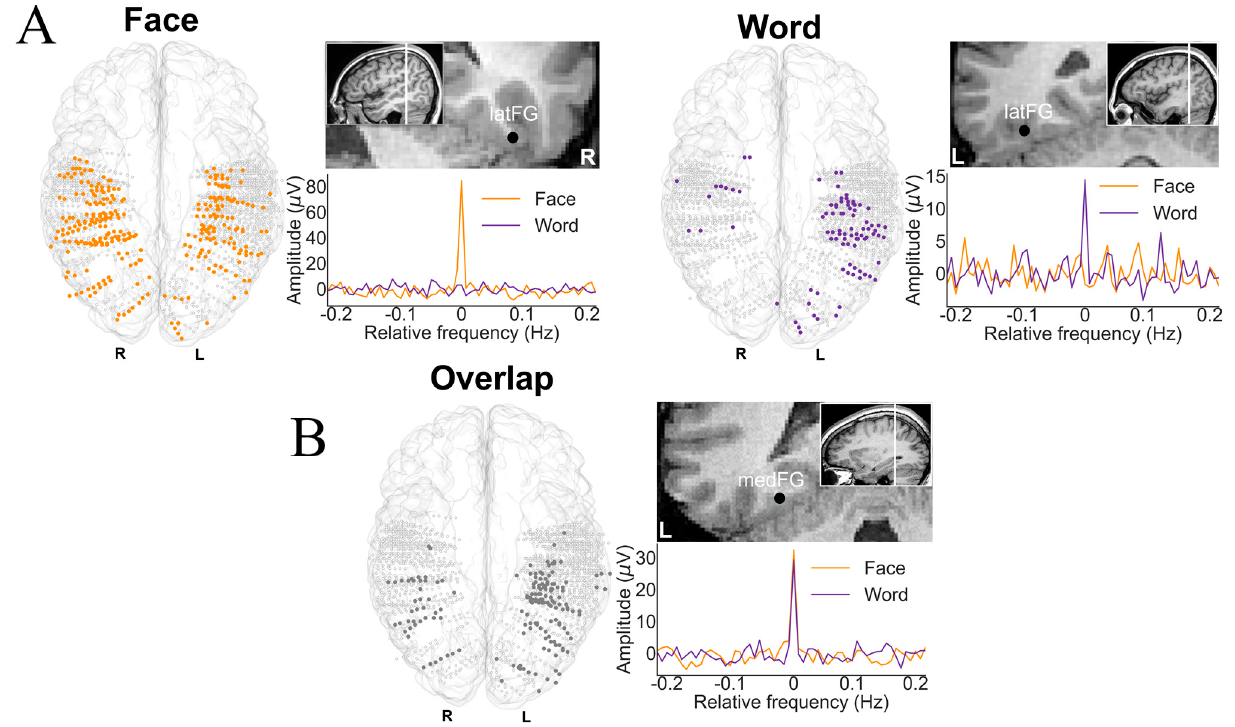
Figure 13. From Hagen et al., 2021 [168]. ( A ) respective localization of significant face-selective contacts with no selective response to words, and vice-versa (with example contacts illustrated). Note the larger number of significant contacts for faces, with an RH advantage, and the large LH dominance for word-selective contacts (as reported in [170]). ( B ) Distribution of contacts showing significant responses to both categories, mainly in the left